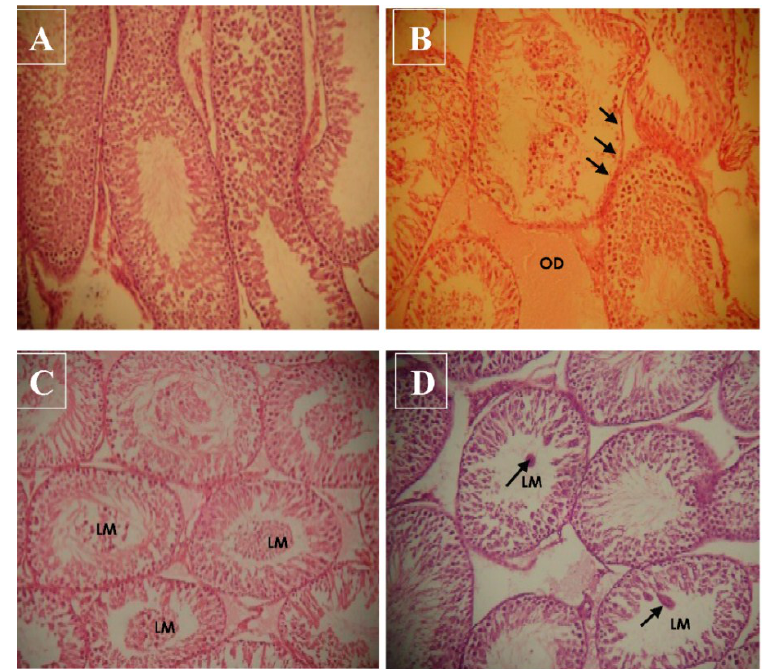
Figure 5. Representative photomicrograph of the testicular sections showing the morphological changes induced by haloxyfop- p -methyl ester in the testes of rats (hematoxylin and eosin stain, 200×); control group ( A ) and treated groups at the doses of 6.75 mg/kg bw ( B ), 13.50 mg/kg bw ( C ) and 27.00 mg/kg bw ( D ). ( A ) shows normal testicular structure; in ( B